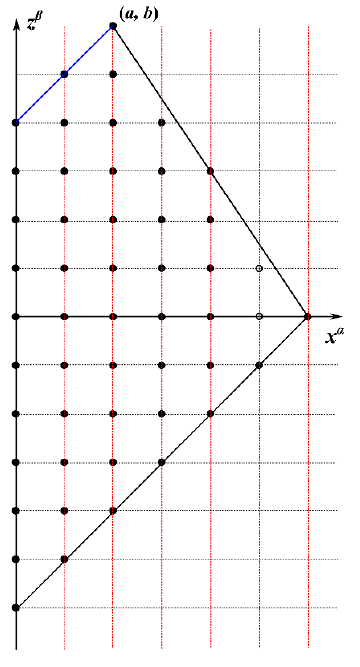
Figure 1 . An example of Newton polygon for A 5 theory with semisimple grading. Each black dot represents a monomial in SW curve. The white dots mean that the monomials are omitted. The letters have scaling dimension [ x ] = 3 = 5, [ z ] = 2 = 5. In general, if the vertex at the top has coordinate ( a; b ), then we have the relation ( N (cid:0) a )[ x ] = b [ z ] and [ x ] + [ z ] = 1. A useful diagrammatic approach to represent SW curve is to use Newton